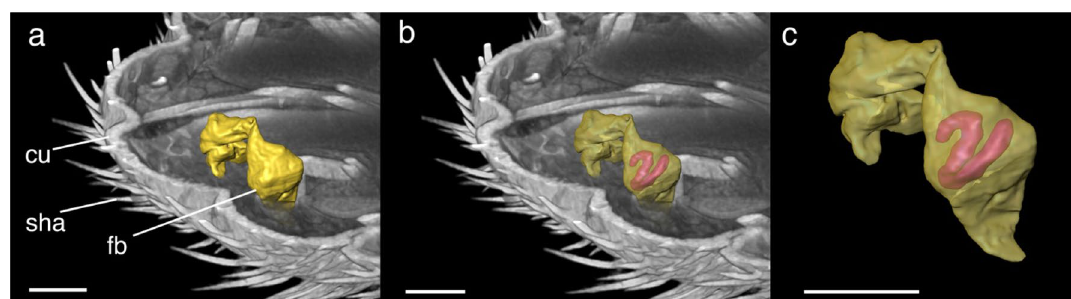
Figure 4. 3D reconstruction of fat body element of Echinophthirius horridus . ( a ) Yellow marked fat body, ( b ) revealing a plump, sausage-shaped Acanthocheilonema spirocauda larva (potentially L1-stage) inside. ( c ) Isolated fat body, containing A. spirocauda larva. Scale bars: 100 µm. Abbreviations: cu = cuticle, fb = fat body, sha = setae modified to